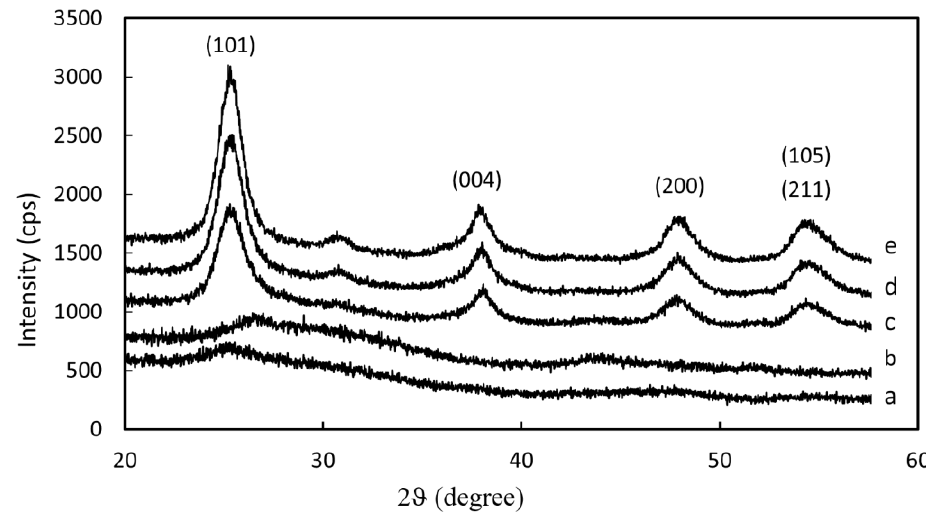
Figure 1. XRD patterns of TiO 2 ( a ), CdS/TiO 2 -1 ( b ), CdS/TiO 2 -4 ( c ), CdS/TiO 2 -2 ( d ) and CdS/TiO 2 -3 ( e ). CdS/TiO 2 -1 shows the typical profile of an amorphous material, presenting only some wide halos related to the presence of the short range order anatase phase of TiO 2 (at 2 θ ≈ 25 ◦ , JCPDS pattern 00-021-1272) [39] and probably some residues of very small 45 ◦ , JCPDS card 00-010-0454), as the positions correspond to the two principal reflections